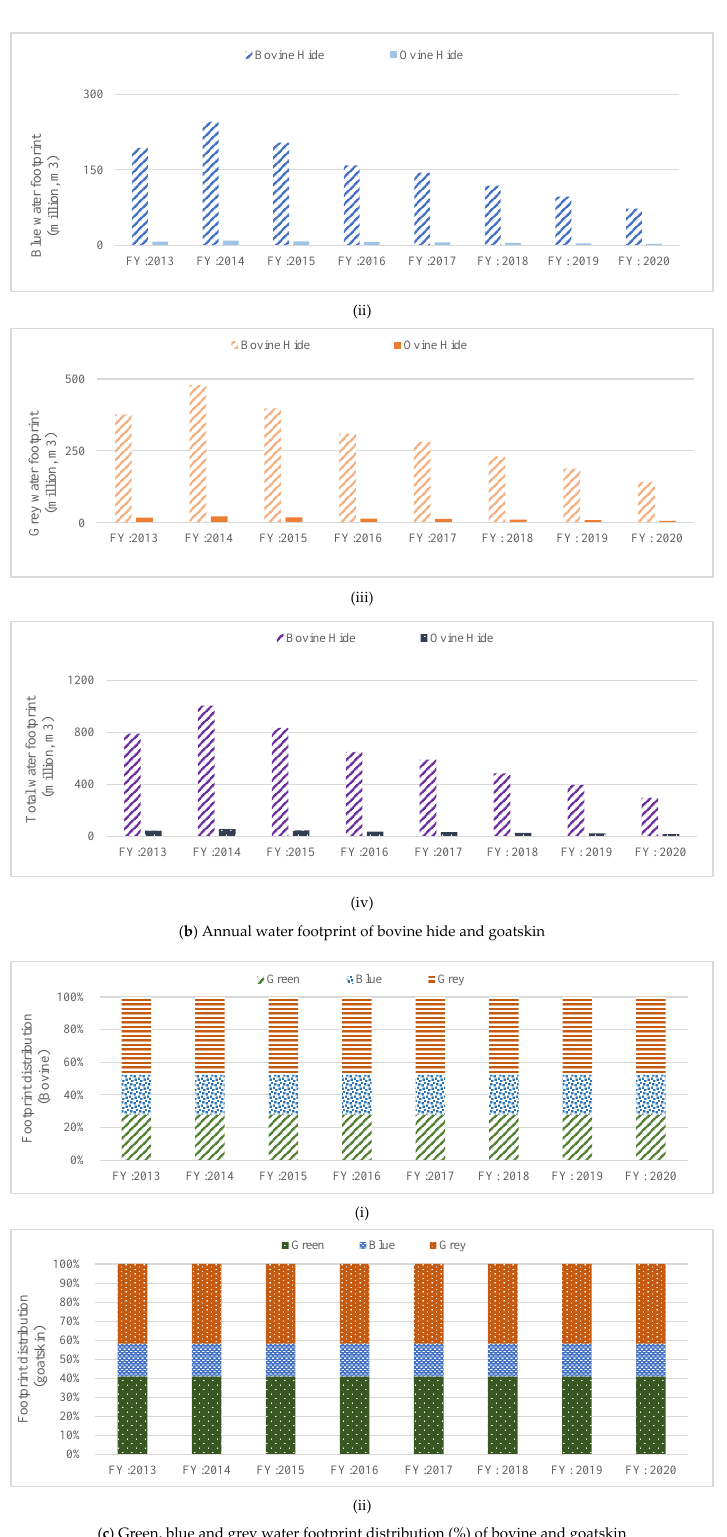
Figure 7. Water footprint of feed crops, bovine hide and goatskin. ( a ) Green, blue and grey water footprint distribution (%) of feed crops. ( b ) Annual water footprint of bovine hide and goatskin ( i )